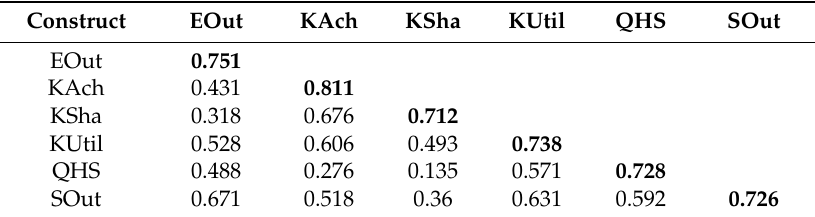
Table 3. Discriminant validity.